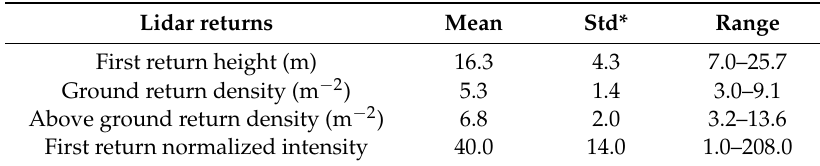
Table 2. Summary of the lidar data for the Montmorency Forest study